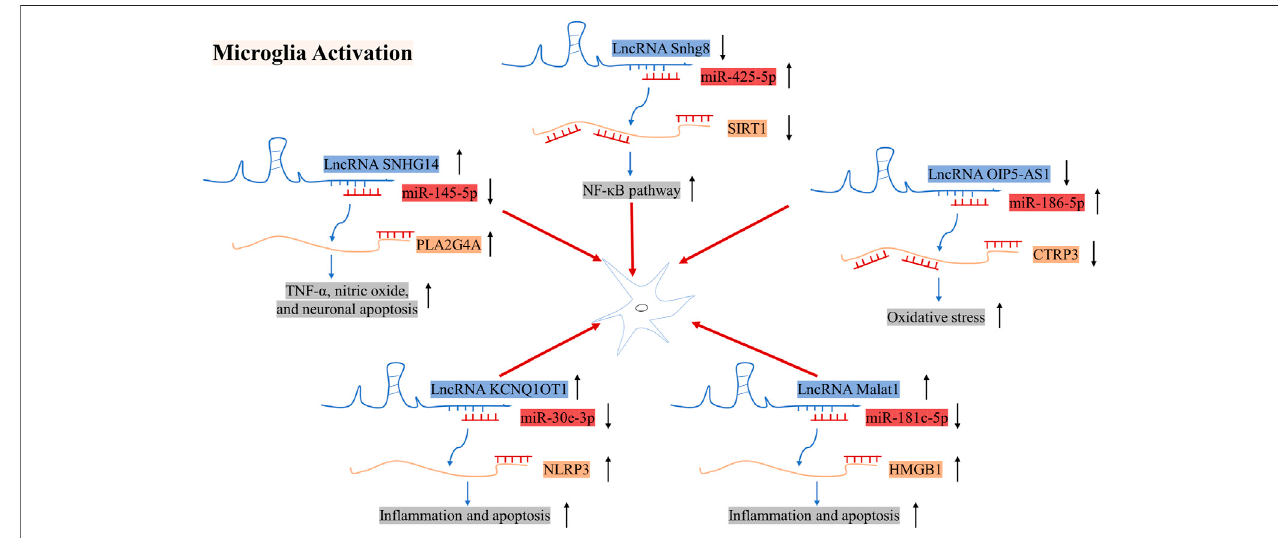
FIGURE 5 | Mechanisms of action of LncRNA SNHG14, Snhg8, and OIP5-AS1 in microglial cells in the pathogenesis of IS. ↑ indicates upregulation, whereas ↓ indicates